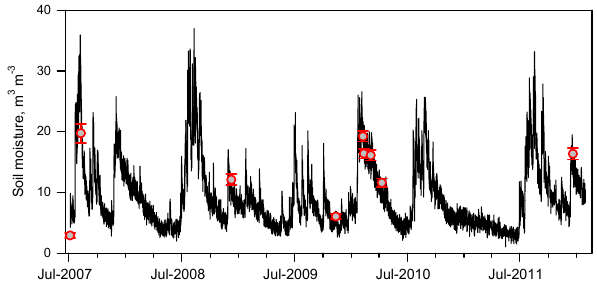
Fig. 7. Soil moisture from cosmic-ray neutron measurements (line) compared to that from gravimetric measurements on samples col- lected within the cosmic-ray footprint (symbols), San Pedro River valley, Arizona. The neutron data are corrected for temporal vari- ations in the incoming neutron intensity, atmospheric pressure and atmospheric water vapor. The gravimetric measurements are aver- ages of between 27 and 108 soil samples. The mean of nine absolute differences between the two is 0.013m 3 m − 3